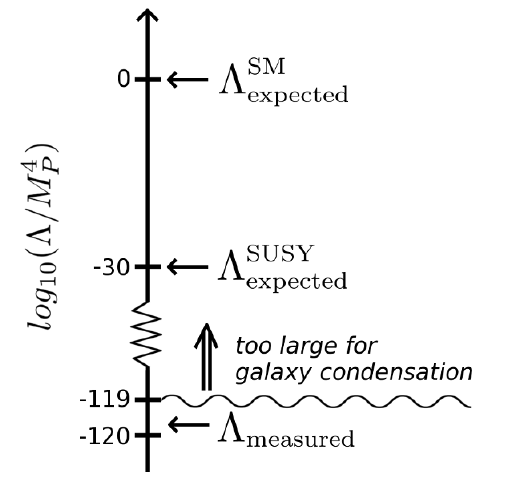
Figure 1. Log portrayal of expected parameter space of the cosmological constant (cid:3) from the string theory